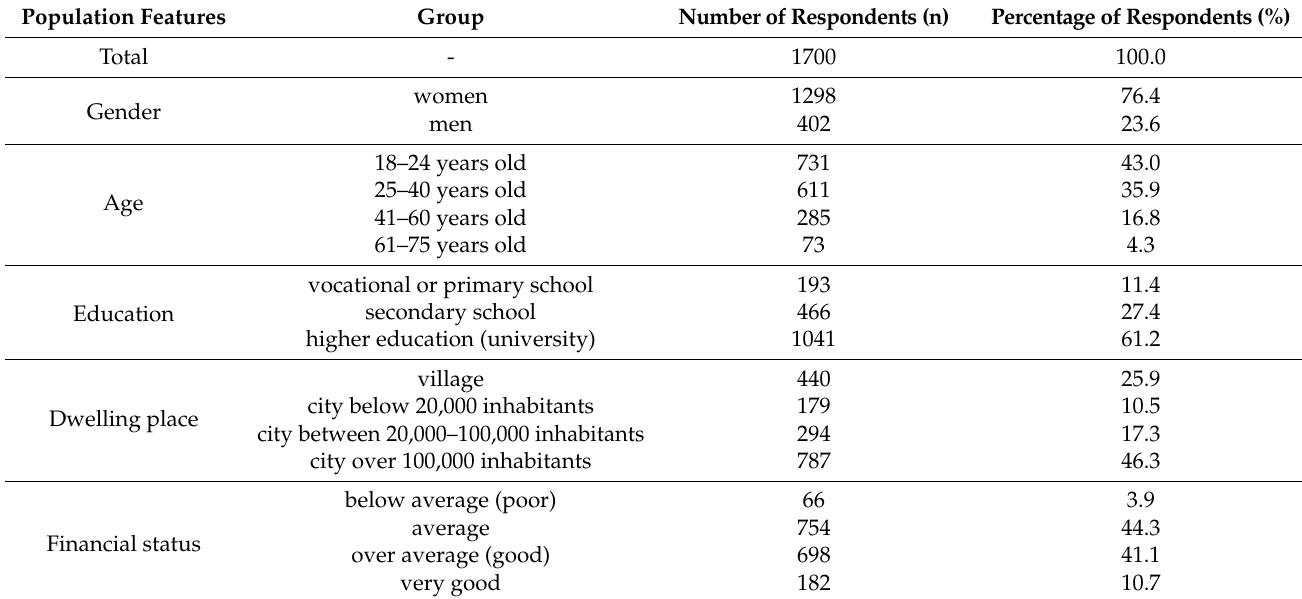
Table 1. Characteristics of the surveyed sample of